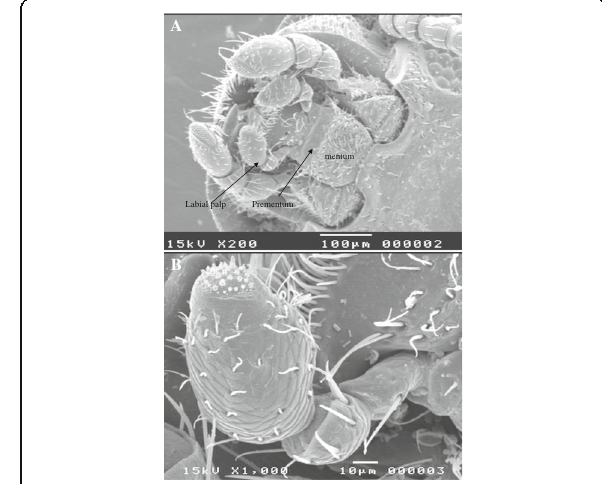
Fig. 5 a Ventral view, of SEM of the mouth parts of adult T. confusum showing the labium which includes the mentum, prementum, ligula (asterisk), and the labial palps. b Higher magnification of the adult labial palp which consists of three segments terminates in a field of